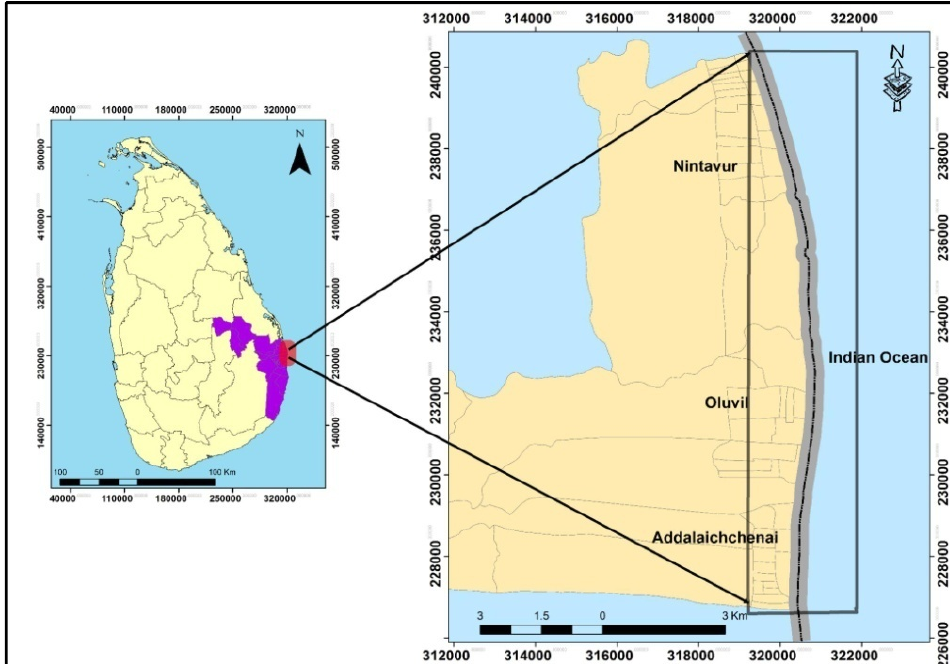
Figure 1. Study area between Nintavur and Addalaichchenai.